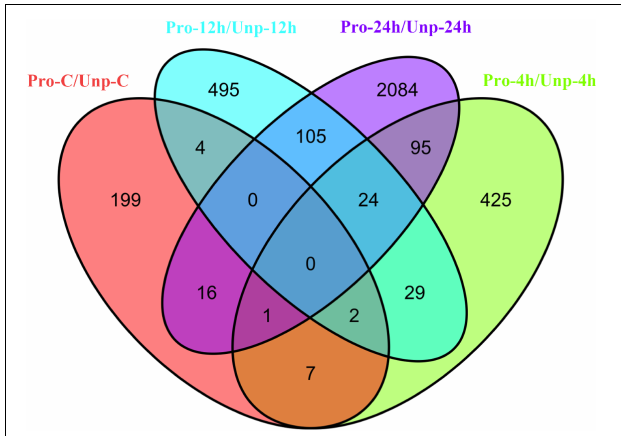
Figure 3 intuitively.